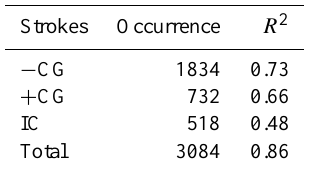
Table 5. Number of occurrences (from 16:00 to 20:25UTC on 15 October) of the different kind of LINET strokes (second col- umn), and R 2 of the linear correlation between strokes and the total amount of IWC g